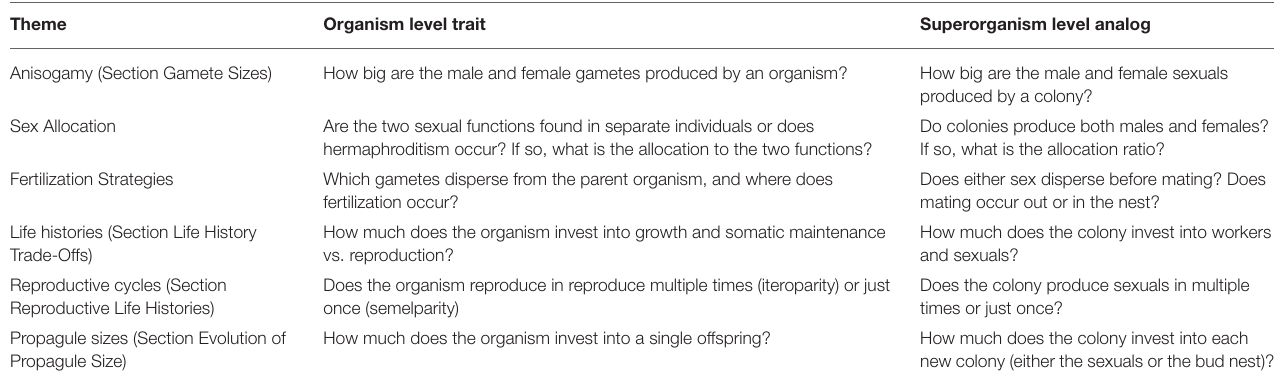
TABLE 1 | The discussed organismal traits and their superorganismal analogs from insect societies. Theme Organism level trait Superorganism level analog Anisogamy (Section Gamete